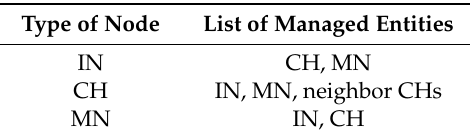
Table 2. The reputation management mechanism.